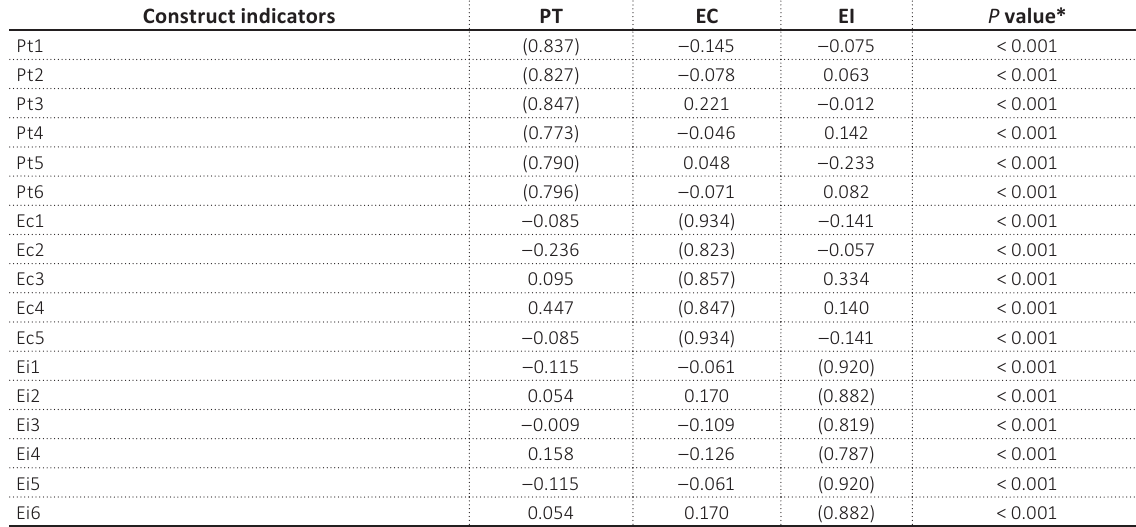
Table 4. Combined loadings and cross-loadings Construct indicators